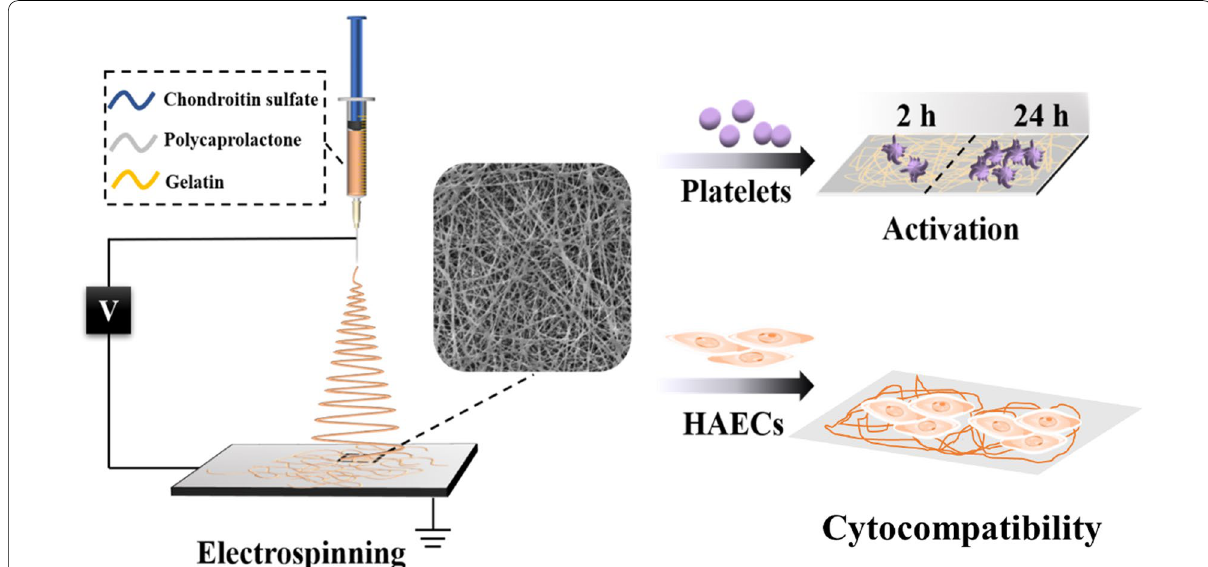
Fig. 1 Schematic illustration of the fabrication of nanofibers and in vitro